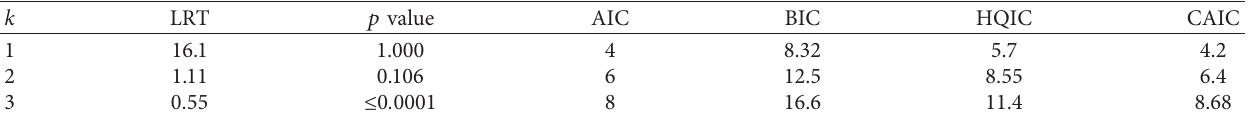
Table 8: Sequential results for application 2 at n �